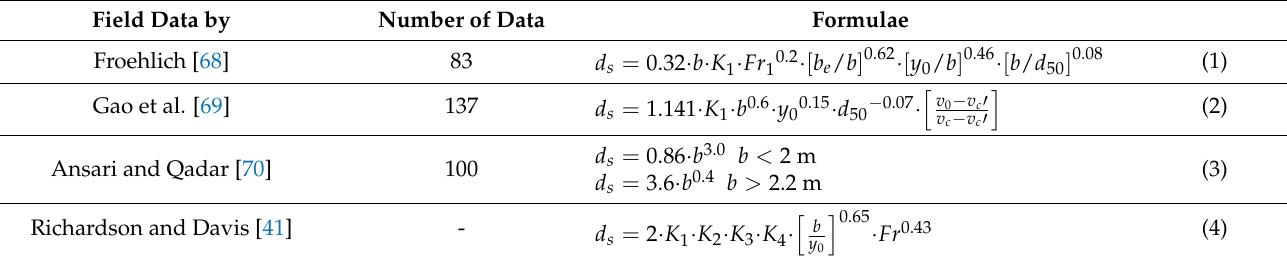
Table 1. Local scour data obtained by field survey and corresponding formulae. Field Data by Number of